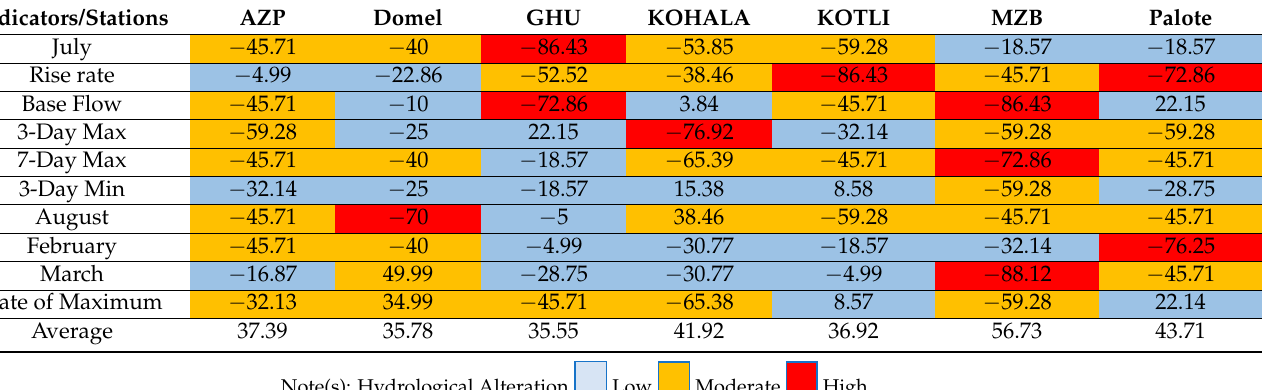
Table 3. Hydrological Alteration (%).